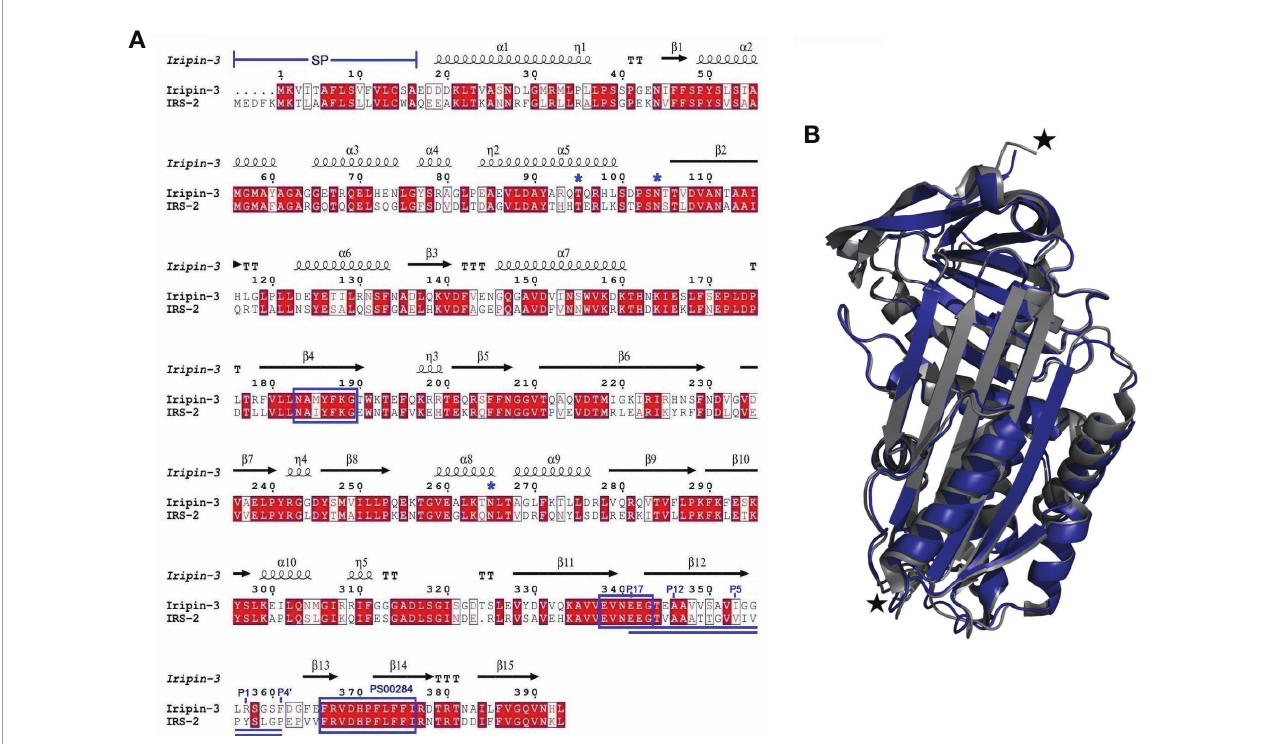
FIGURE 1 | A comparison of the primary, secondary and tertiary structures of Iripin-3 and IRS-2. (A) Structure-based sequence alignment of Iripin-3 and IRS-2. Secondary structure elements, which are shown above the aligned sequences, are depicted as spirals ( a -helices, 3 10 -helices) and arrows ( b -sheets). Both Iripin-3 and IRS-2 possess a signal peptide (SP) at the N terminus of their sequences. Conserved AA motifs PS00284, N-[AT]-[VIM]-[YLH]-F-[KRT]-[GS], and [DERQ]-[VL]- [NDS]-E-[EVDKQ]-G are boxed in blue. The RCLs of both serpins are double underlined. Numbering of amino acid residues in the RCL is based on the standard nomenclature developed by Schechter and Berger (67). Putative N-glycosylation and O-glycosylation sites are marked with blue asterisks. (B) Superposition of the cleaved Iripin-3 structure (blue) on the structure of cleaved IRS-2 (gray). Cleavage sites are marked with black